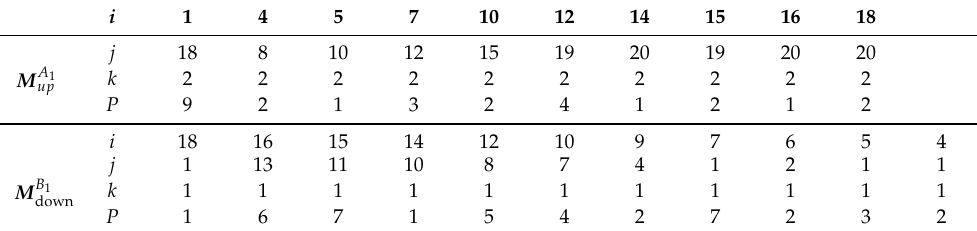
Table 4. Scheduling tasks of Elevator-AB in the first half cycle.